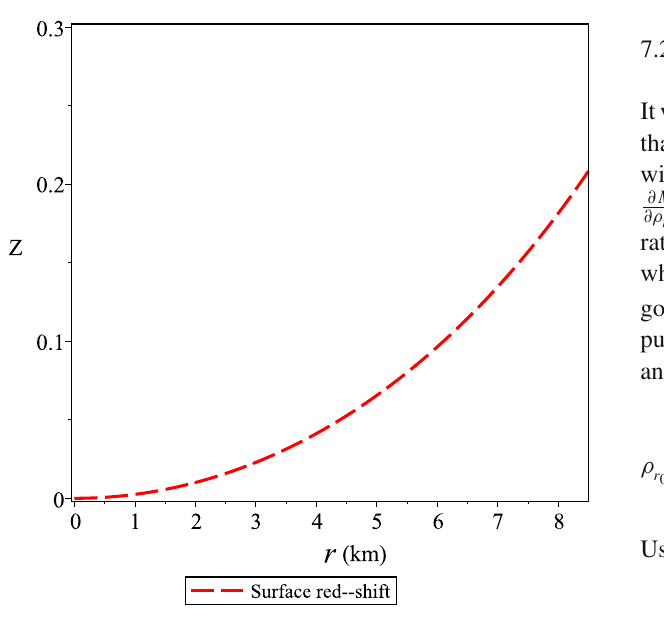
Fig. 9 Plot of the Mass function vs the radius r using the constants constrained by PSR J 1614-2230